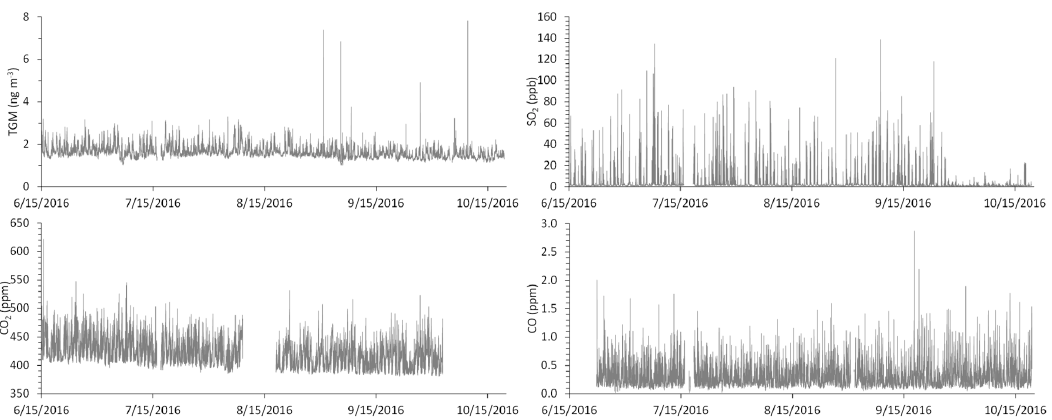
Figure 2. Continuous measurements of ( a ) total gaseous mercury (TGM), ( b ) SO 2 , ( c ) CO 2 , and ( d ) CO at the measurement site from June 15 to October 20, 2016. TGM data are five-minute integrated measurements. SO 2 , CO 2 , and CO data are five-minute averages of 1-minute measurements. Using hourly-averages of the five-minute observations, we find that TGM is significantly positively correlated with CO 2 (R = 0.62, p < 0.001) and relative humidity (R = 0.43, p < 0.001), but it is negatively correlated with wind speed (R = − 0.40, p < 0.001) (Table SI-2). Interestingly, TGM and SO 2 are uncorrelated (R = − 0.06, p = 0.002); instead, SO 2 is positively correlated with temperature (R = 0.28, p < 0.001) and wind speed (R = 0.36, p < 0.001), but not strongly correlated with any of the other